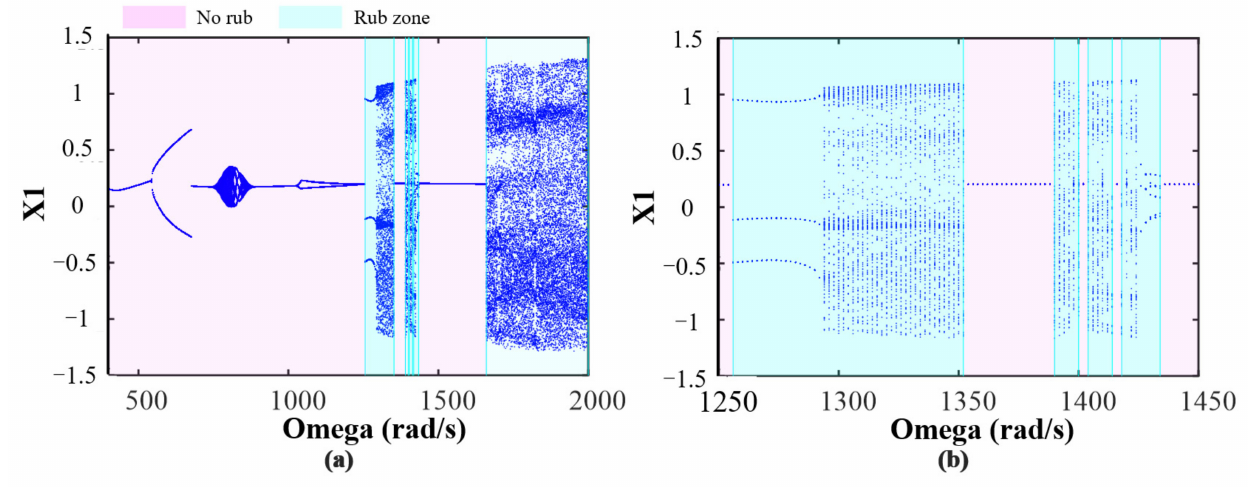
Figure 14. Bifurcation diagrams of the rotor system at the position of disc 1 for the case of disc 2 subjected to rub-impact: ( a ) ω = [400~2000] rad/s; ( b ) Local bifurcation diagram.